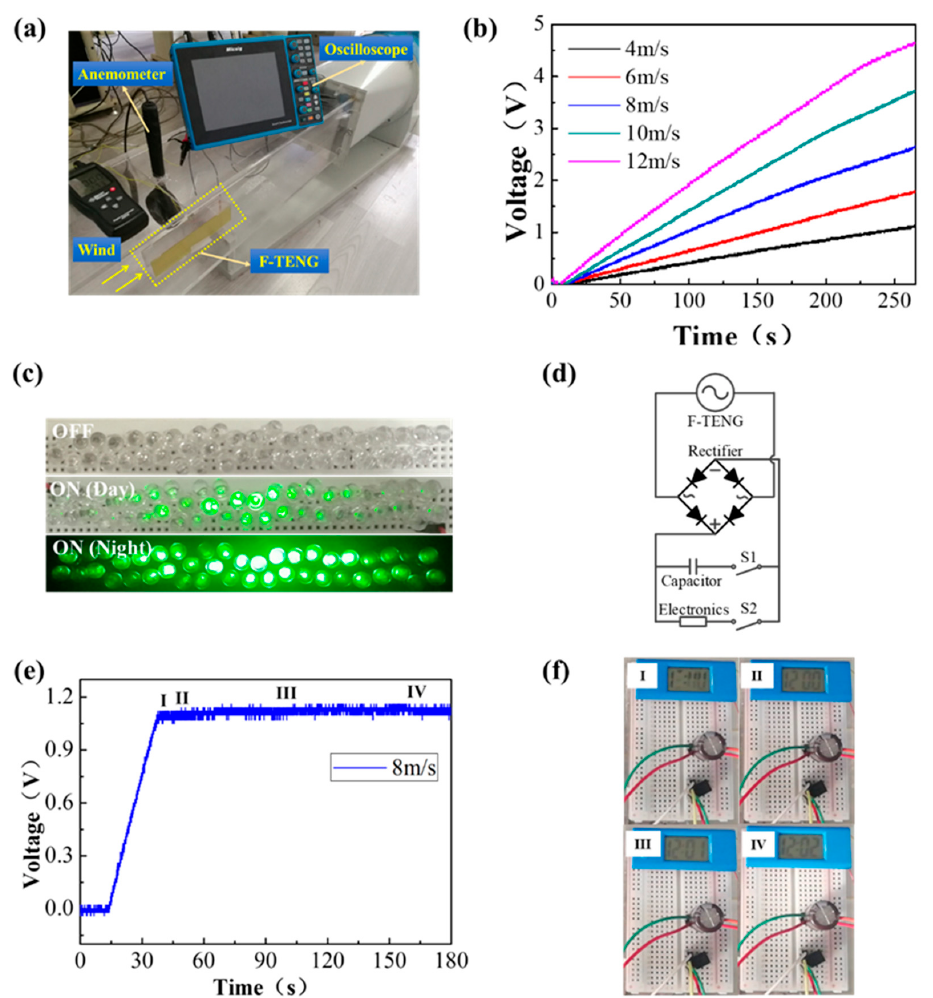
Figure 4. ( a ) The measurement and application setup of FTENG, ( b ) Charging a 100 μ F capacitor at different wind speeds, ( c ) Lighting up dozens of LEDs by FTENG, ( d ) The equivalent circuit for powering electronic devices via a capacitor, ( e , f ) Continuously powering a digital watch.